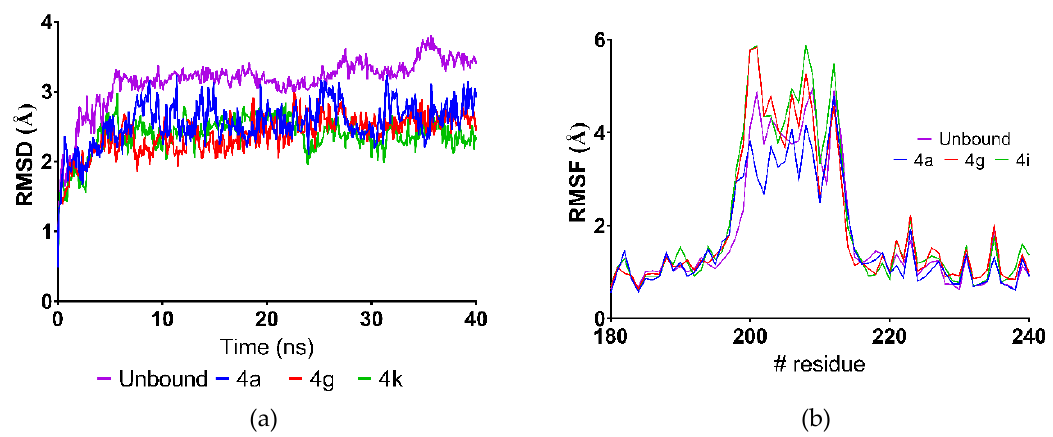
Figure 7. ( a ) RMSD along simulation time plot and ( b ) RMSF of residues along dimer interface (residues 180-240) plots generated from data from MD simulations of complexes of 4a , 4g , and 4i with PqsD. Table 3. Average RMSD values and ligand binding energy (LBE) 1 calculated during MD simulations. LasR